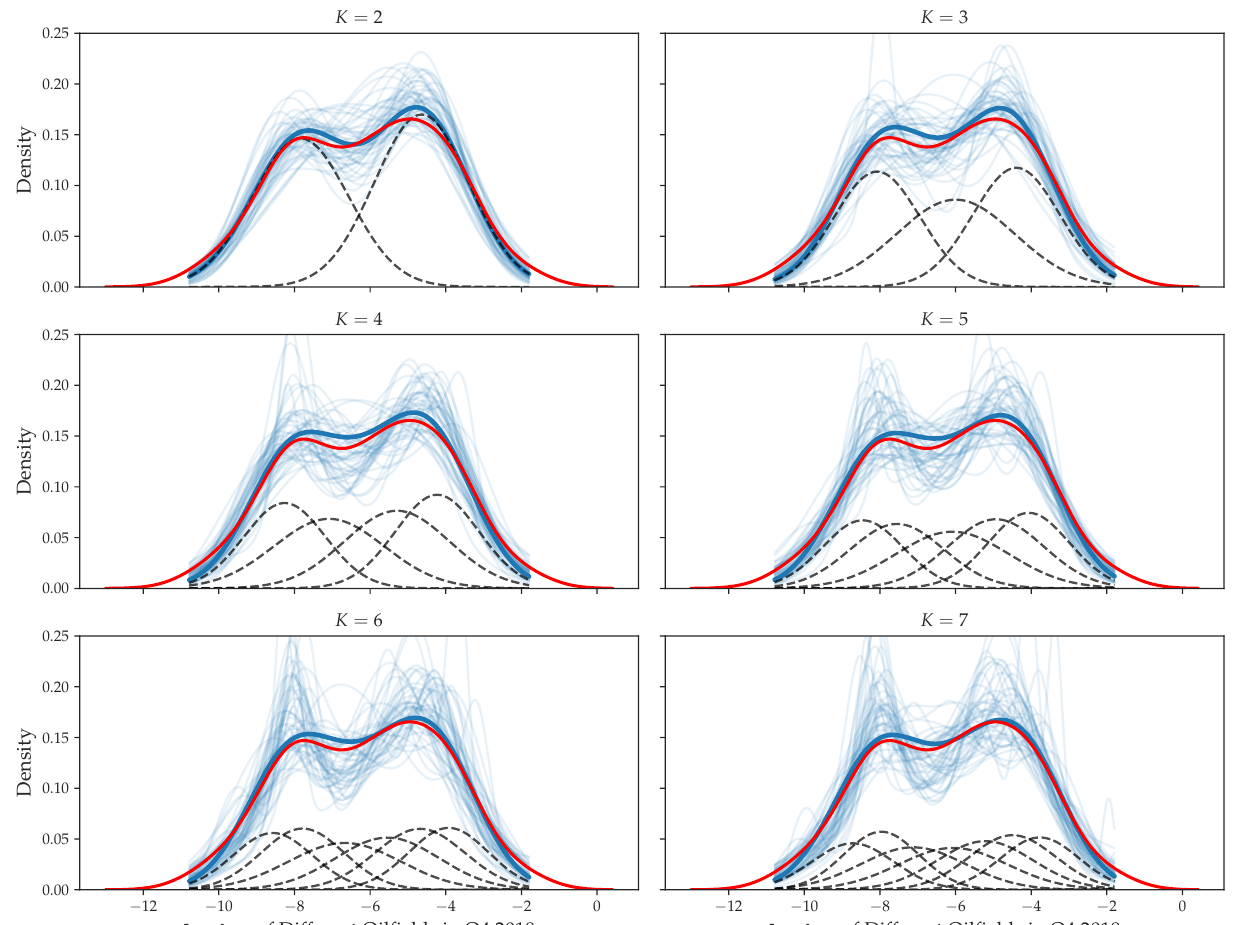
Figure 21. GMM inference results with different K ’s. The thick blue line illustrates the posterior mean density function. The light blue lines represent fifty random posterior samples. The dashed lines mark the inferred mean Gaussian components. The red curve displays the KDE.